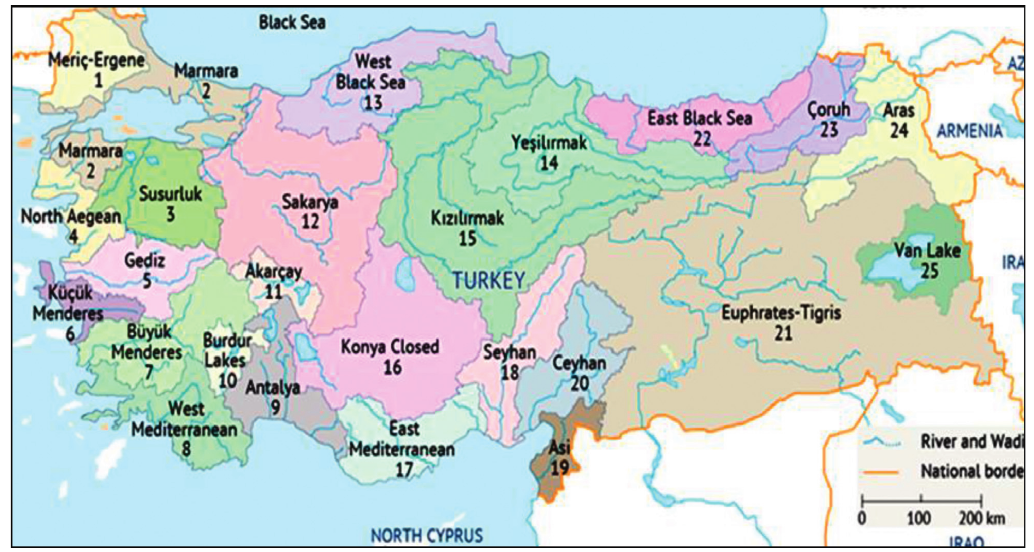
Figure 1: Map of the basins in Turkey [20]. Table 1: Number of stations, size of basins, and observed averaged areal